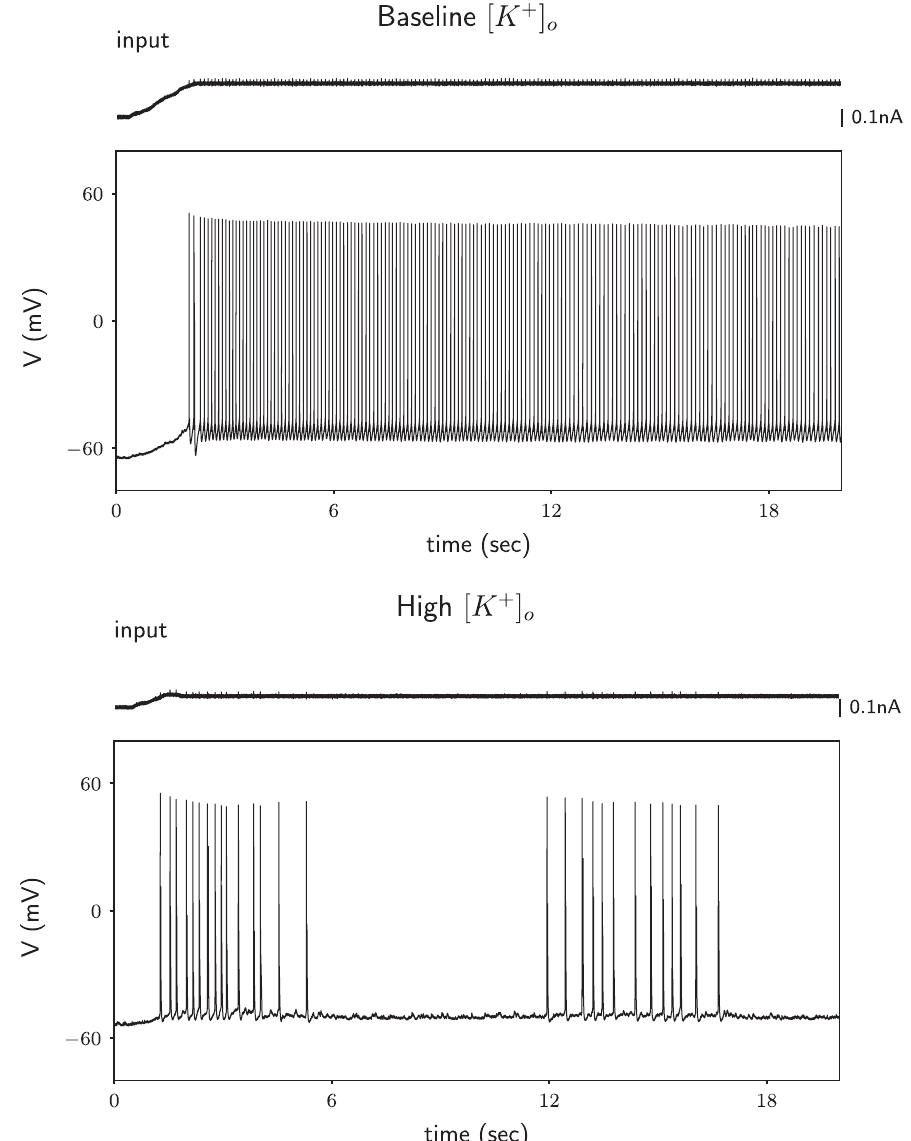
Fig 4. Rodent cortical neurons exposed to high extracellular potassium show intermittently interrupted firing. Example cell; Response of a neuron to a just suprathreshold stimulus in low (3 mM; Top) and high (10 mM; Bottom) extracellular potassium conditions. The suprathreshold current is taken as the current needed to elicit the first spike when injecting a ramp with a shallow slope. The small spikelets visible in the current trace are artifacts resulting from limited capacitive coupling of two channels at the digitizer (i.e., of the action potentials present in the voltage trace), and are not reflective of current injected into the